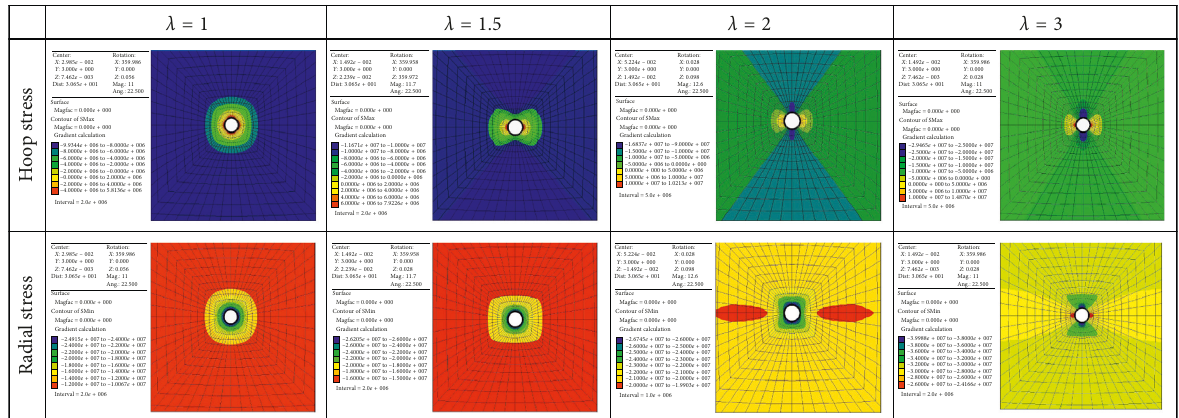
Figure 7: Stress contour around borehole under different lateral coefficients.